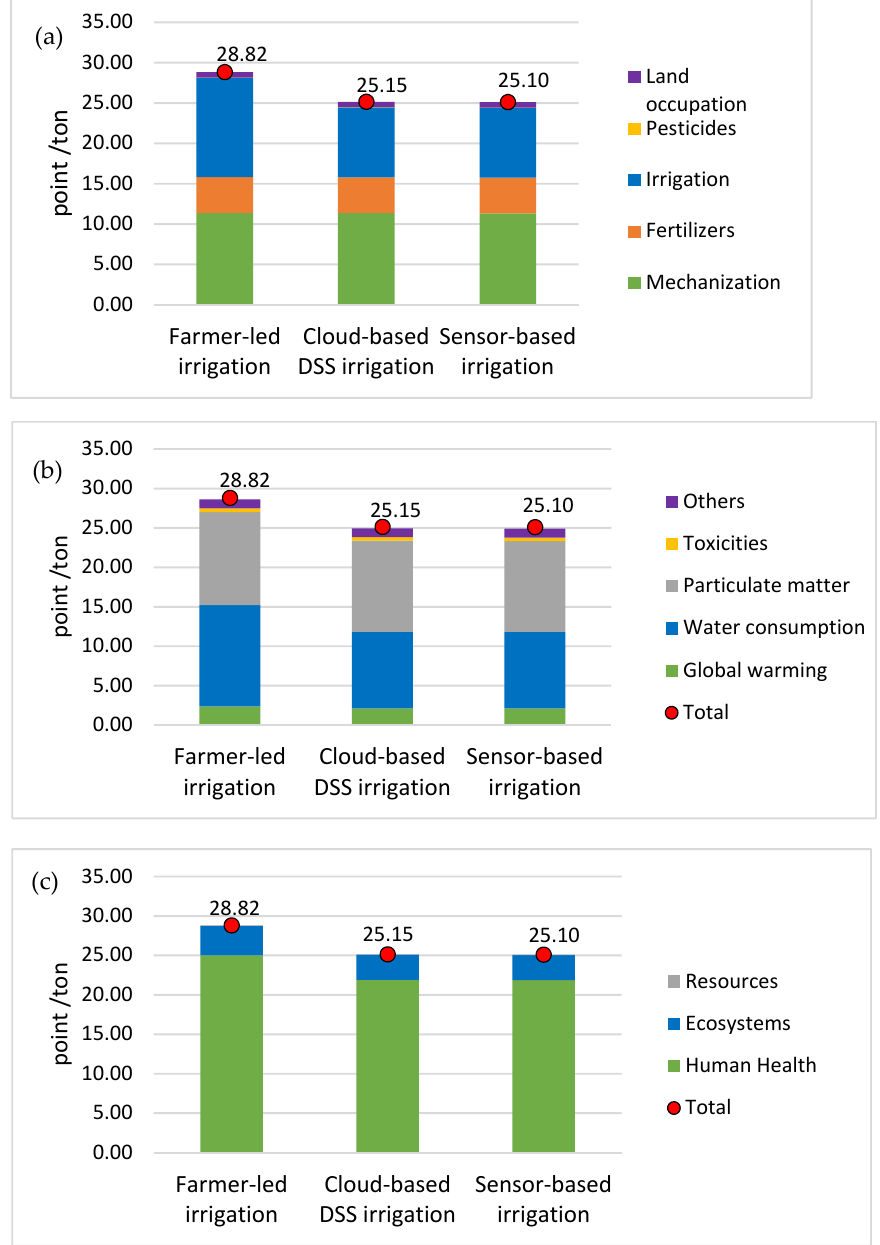
Figure 5. Environmental impact (ReCiPe single score) of Zucchini production under different management strategies showing contribution analysis of ( a ) processes, ( b ) midpoint impact categories, and ( c ) endpoint indicators.